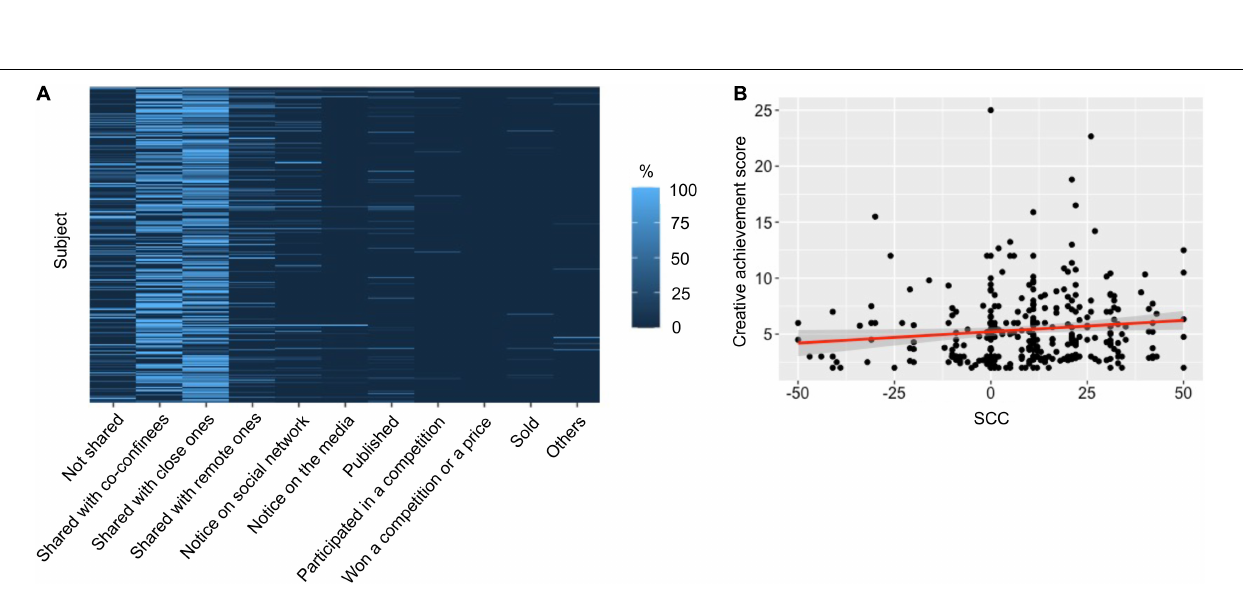
FIGURE 5 | Creative achievements. (A) Proportion of the selected levels of creative achievement averaged across activities for each subject. (B) Individual SCC as a function of individual creative achievement score . The red line indicates a significant correlation between SCC and the creative achievement score (Spearman correlation, p <